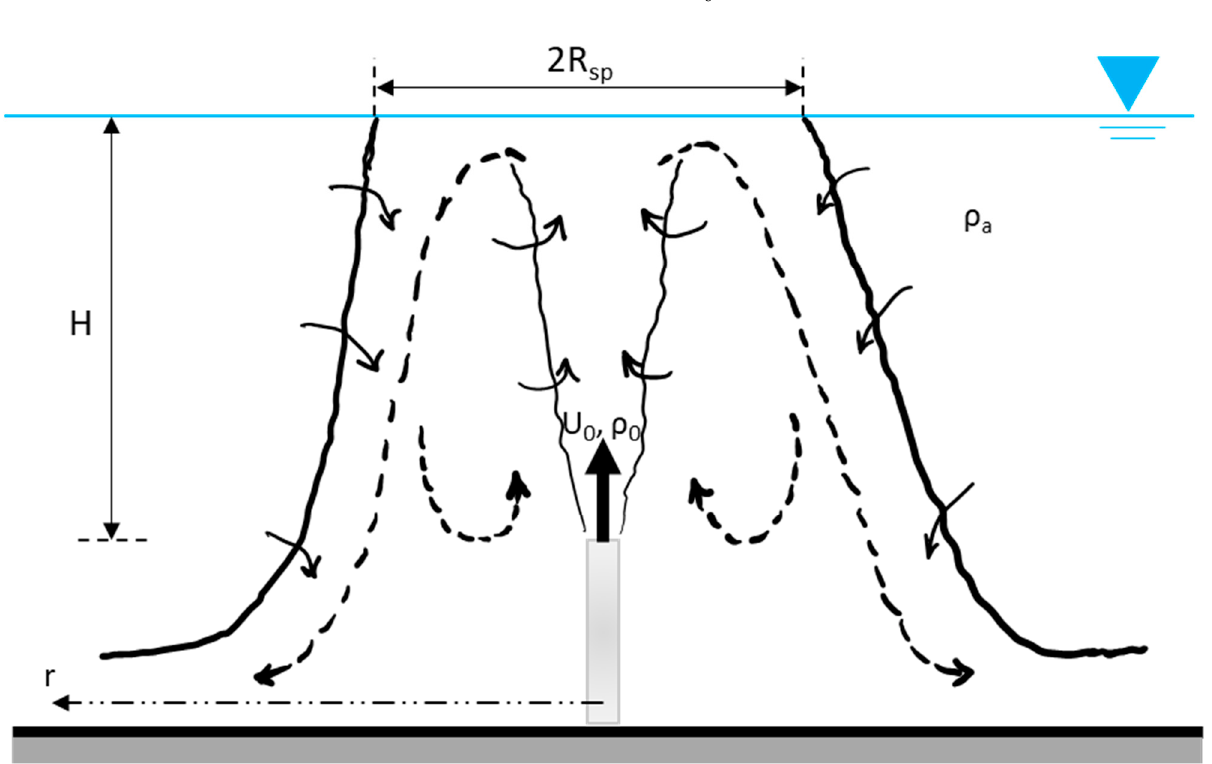
Figure 2. Schematic representation of dense effluent discharge with surface attachment.